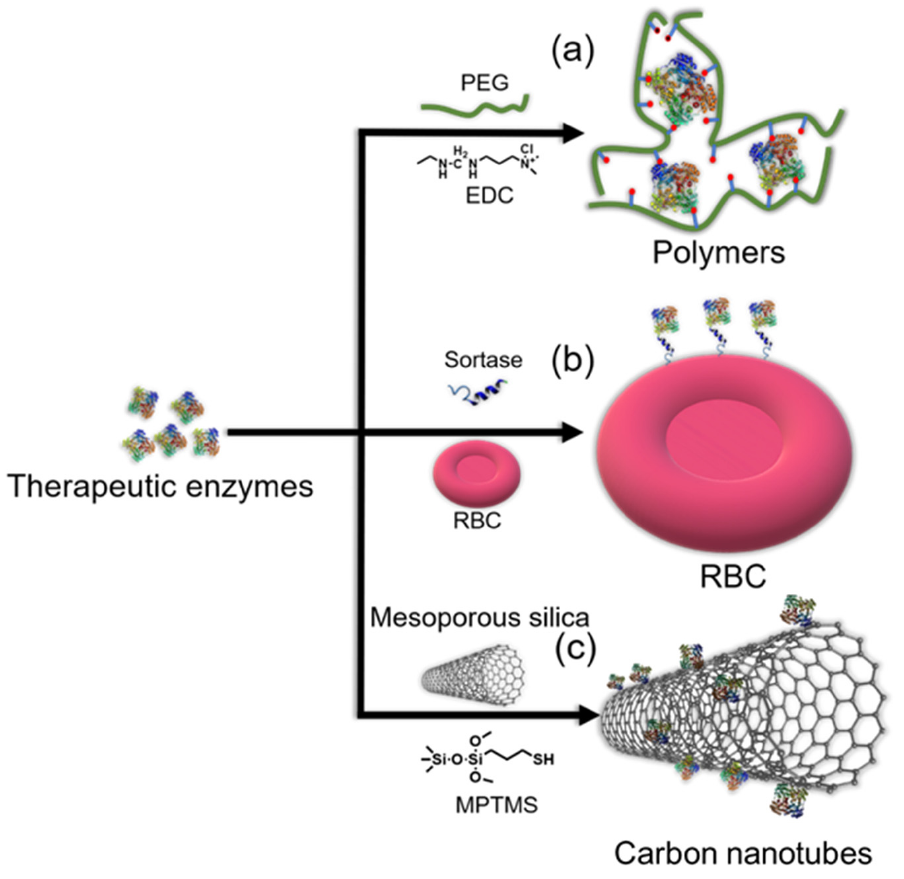
Figure 4. Illustration of covalent approaches for therapeutic enzyme immobilization via conjugation onto ( a ) polyethylene glycol (PEG), ( b ) red blood cells (RBC), and ( c ) mesoporous silica. Here, EDC and MPTMS denote 1-ethyl-3-(3-dimethyl aminopropyl)carbodiimide and mercaptopropyltrimethoxysilane, respectively.